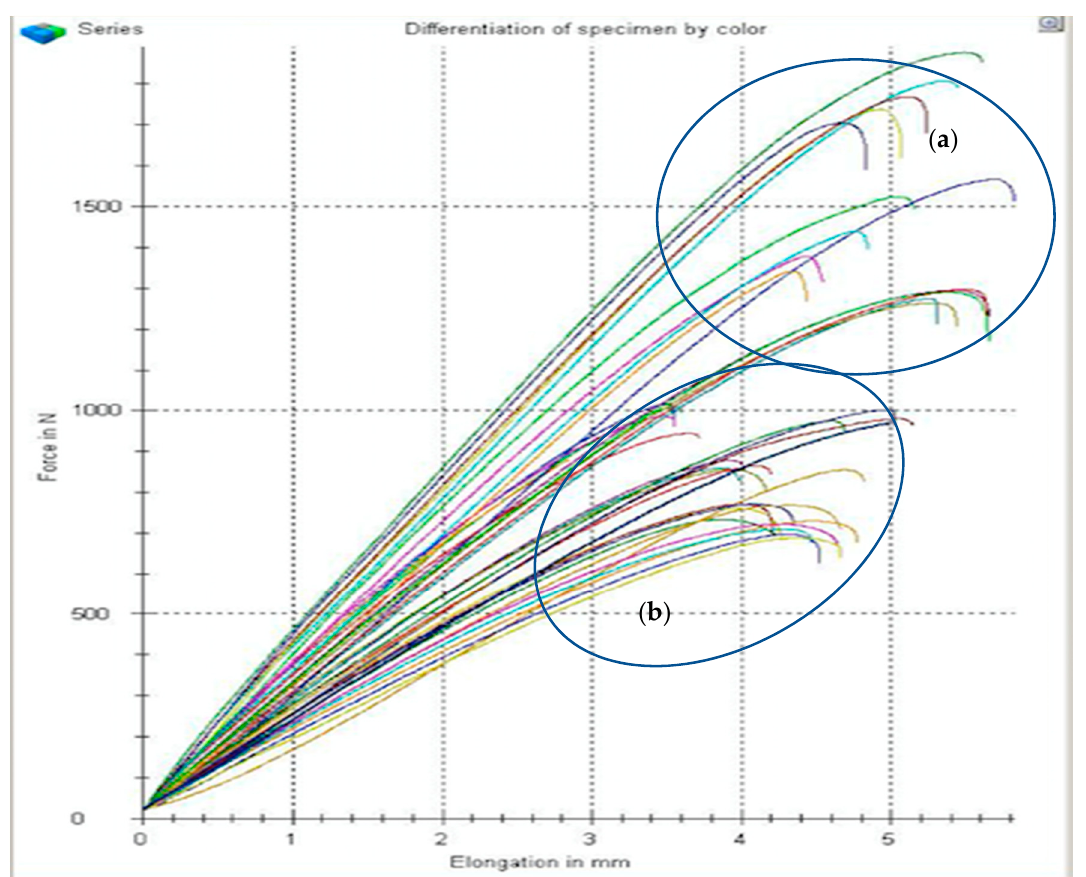
Table 6. Tensile strength and elongation at break of recycled PET filament.